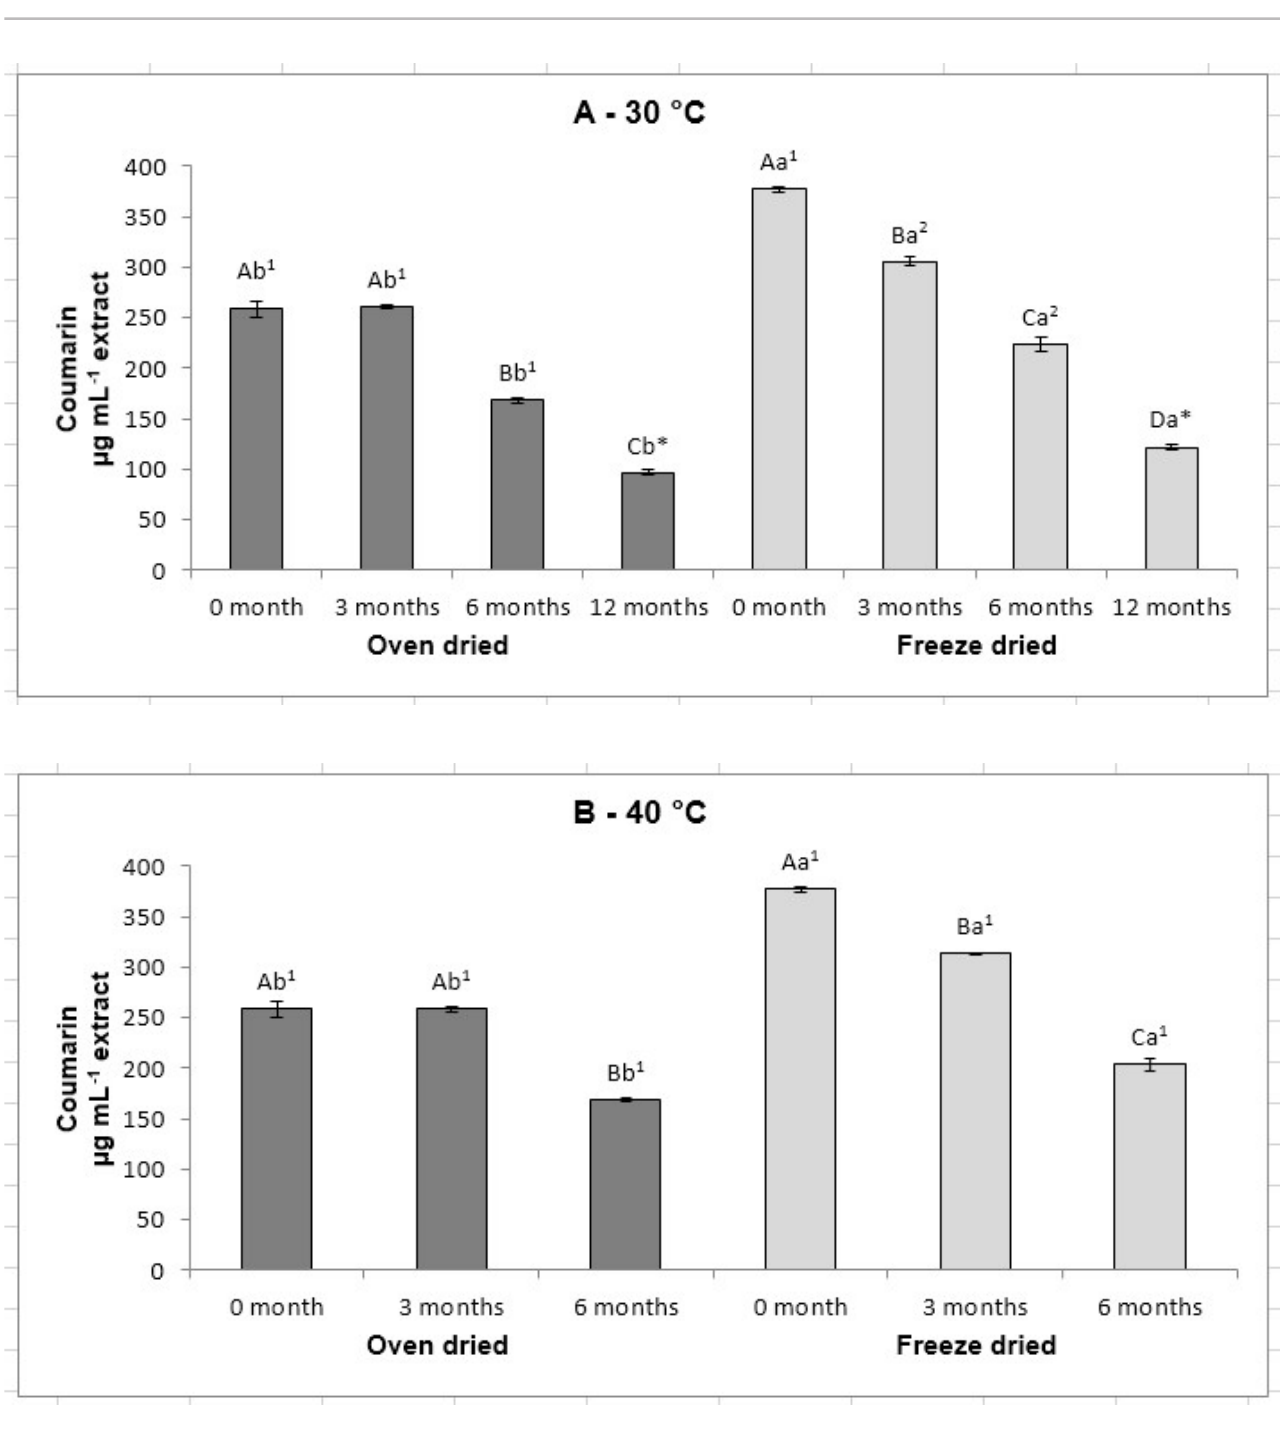
FIGURE 3 - Variation of the content of coumarin in extracts of oven dried and freeze-dried M. laevigata leaves. (A) long-term stability study at 30 ºC and (B) accelerated stability study at 40 ºC. (*) Indicates no data collected for this group. Capital letters indicate statistically significant (p<0.05) differences within the same drying method (0, 3, 6 and 12 months). Lowercase letters indicate statistically significant (p<0.05) differences between drying methods at the same time. Numerals indicate statistically significant (p<0.05) differences between storage temperatures (30 ºC and 40 ºC). Experiment performed in triplicate. Error bars indicate standard